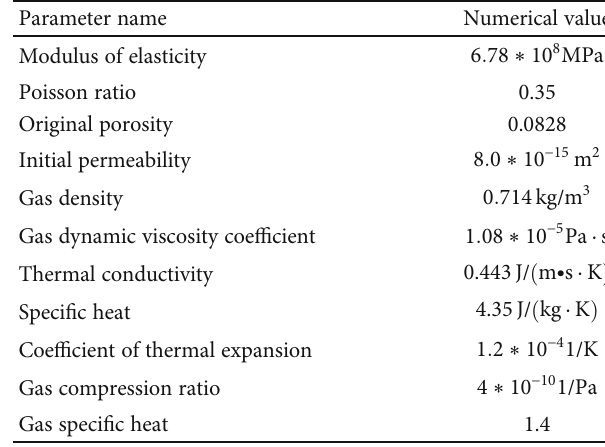
Table 1: The material parameters of